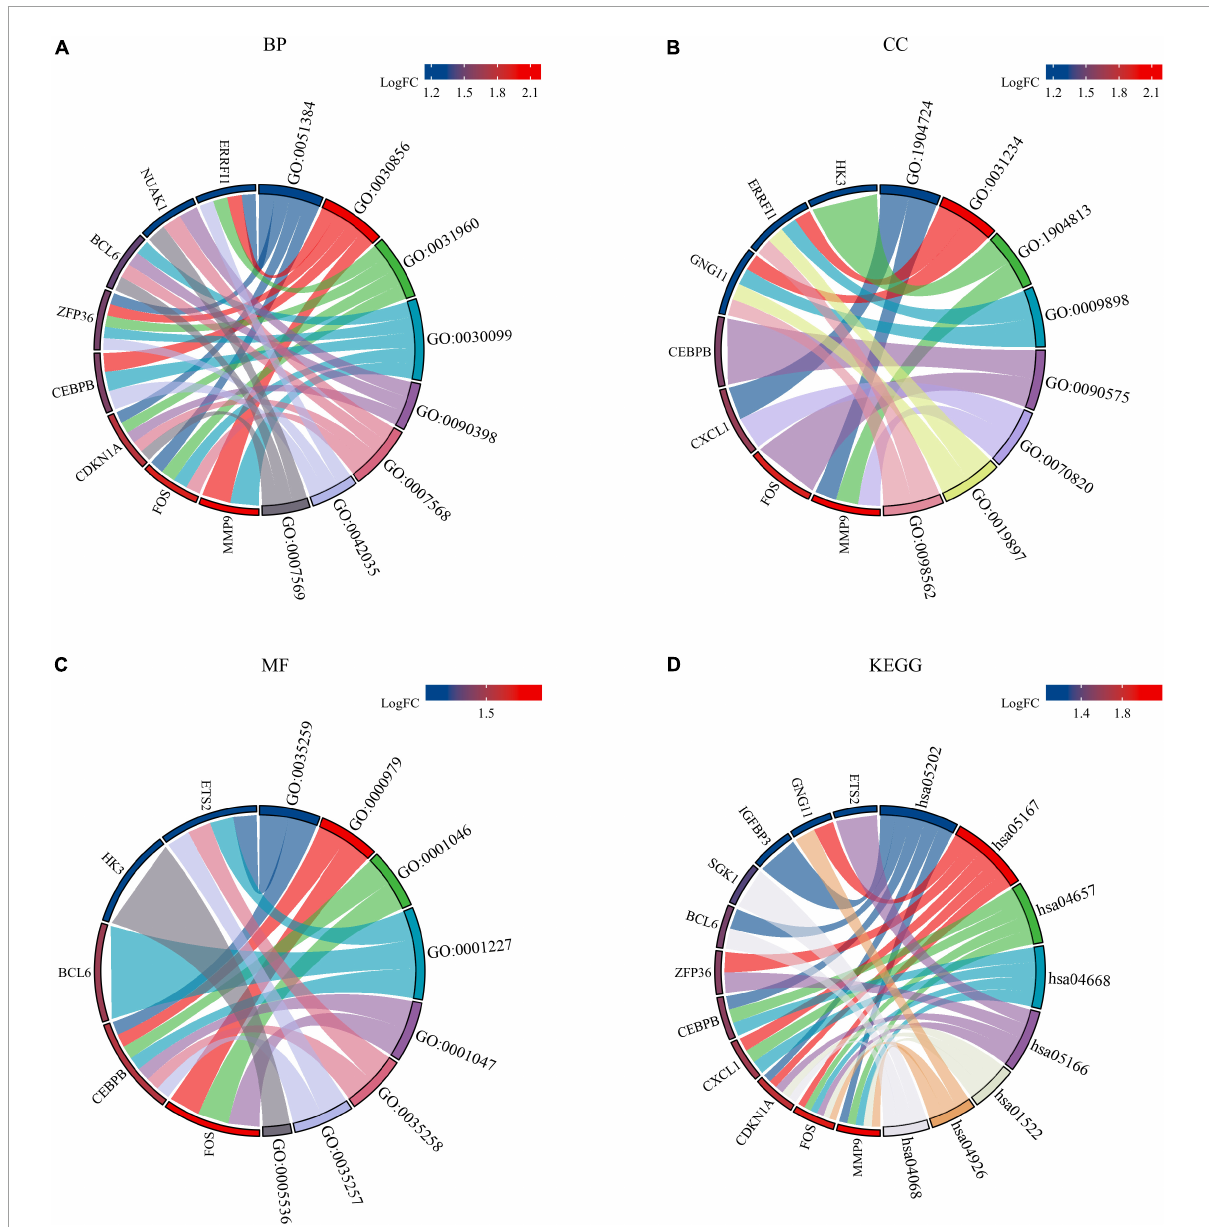
FIGURE6 Chord plots of 14 DESRG-enriched GO terms and KEGG pathways. Panels (A–D) represent the top eight enriched items and their enriched genes of BP, CC, MF, and KEGG, respectively. GO, Gene Ontology; KEGG, Kyoto Encyclopedia of Genes and Genomes; BP, biological process; CC, cellular component; MF, molecular function; DESRGs, differentially expressed senescence-related genes.